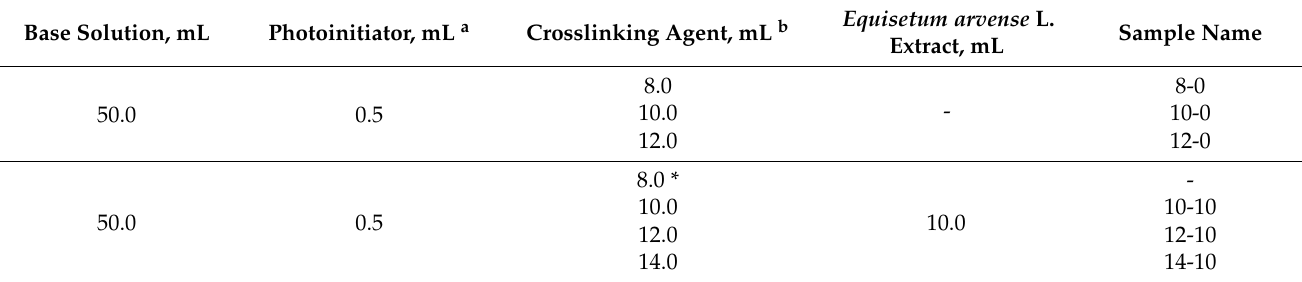
Table 1. Compositions of hydrogels modified with Equisetum arvense L. extract.